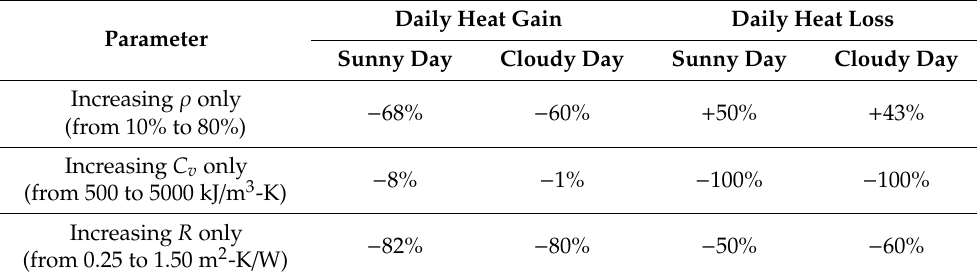
Table 1. E ff ects of thermo-physical and solar radiation properties on daily heat flux performance in a tropical climate. Daily Heat Gain Daily Heat Loss Parameter Sunny Day Cloudy Day Sunny Day Cloudy Day Increasing ρ only − 68% − 60% + 50% + 43% (from 10% to 80%) Increasing C v only − 8% − 1% − 100% − 100% (from 500 to 5000 kJ / m 3 -K) Increasing R